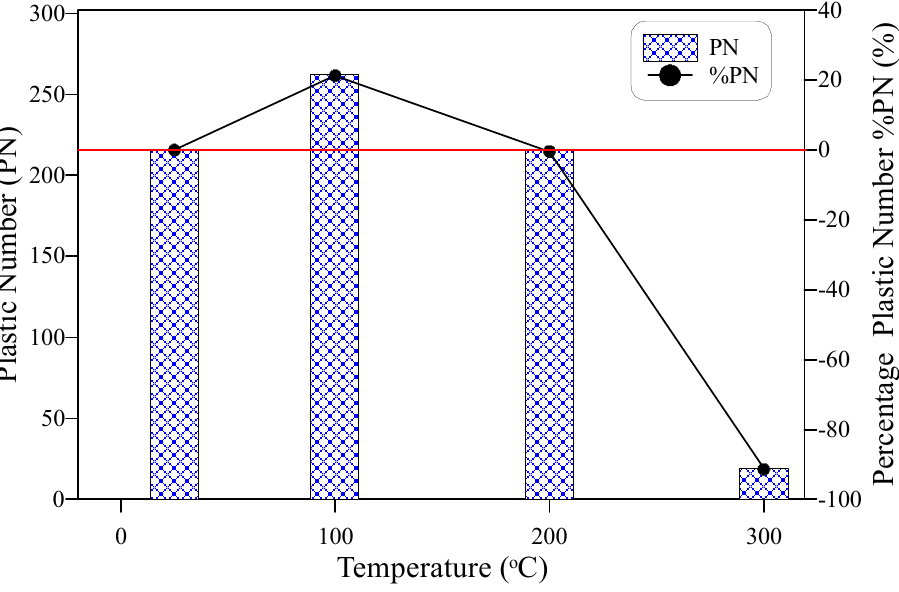
Figure 13. Plastic impact number-temperature